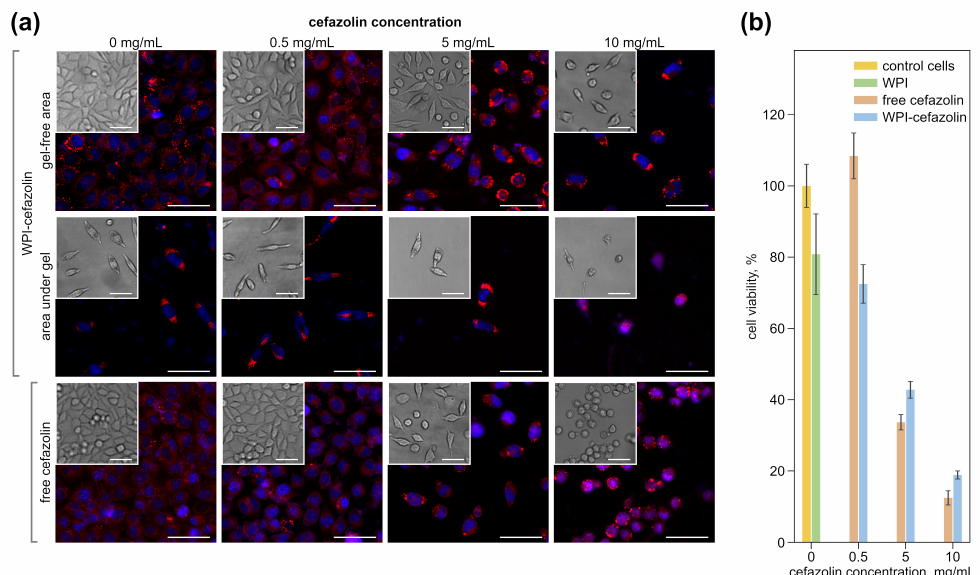
Figure 4. ( a ) CLSM images of L929 incubated with free and immobilized cefazolin (0, 0.5, 5, 10 mg/mL) for 48 h. For immobilized cefazolin, gel-free areas and areas under gel are specified. Blue color indicates nuclei (DAPI), and red indicates lipid components on membrane and inside the cell (Nile red). Images inserted to the left upper corner are brightfield images. Scale bars are 50 µ m. ( b ) Viability of the L929 cell line incubated with free and immobilized in WPI disks cefazolin (0, 0.5, 5, 10 mg/mL) for 48